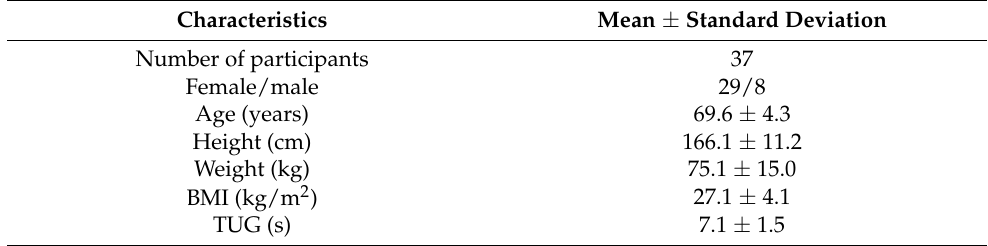
Table 1. Descriptive characteristics of participants.